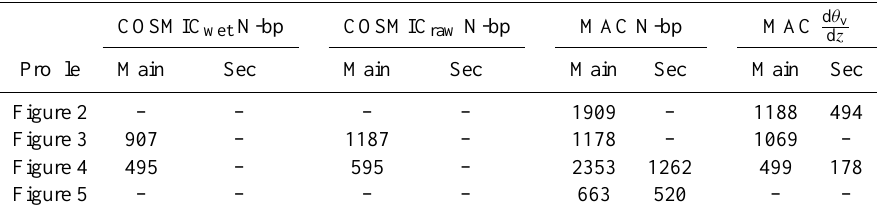
Table 1. Main and secondary inversion heights for MAC and COSMIC using the refractivity profile break point method (N-bp) and the d θ v method for